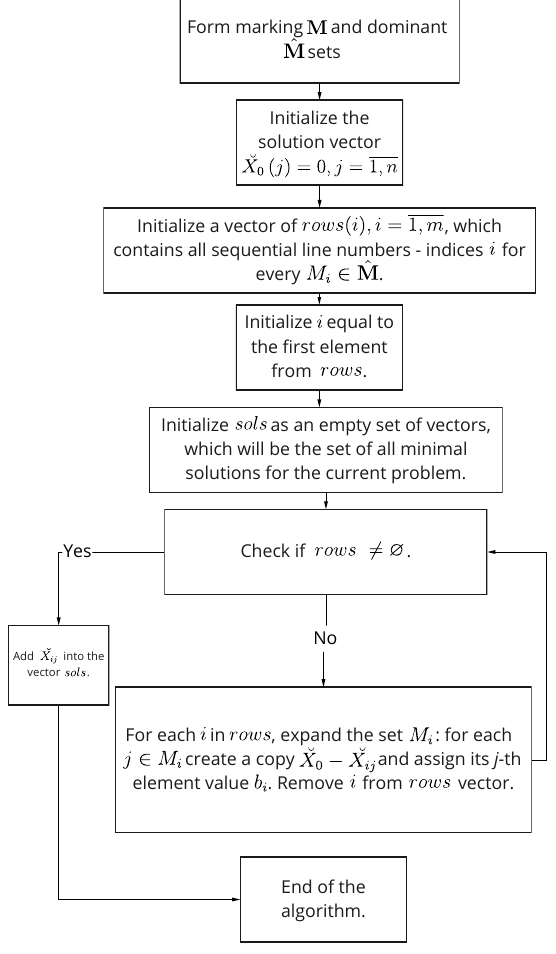
Figure 2. Algorithm for obtaining a lower solution from ˆ M